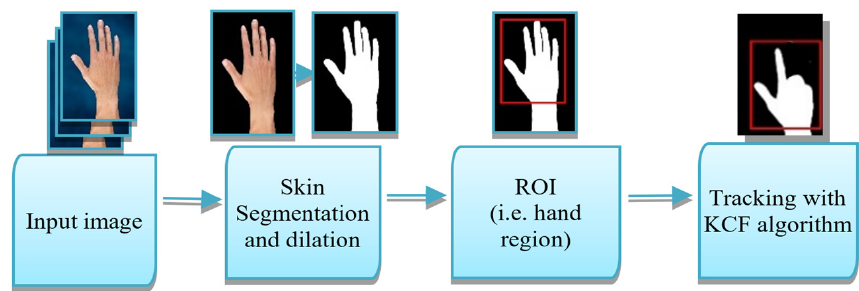
Figure 3. Hand region detection and tracking process.